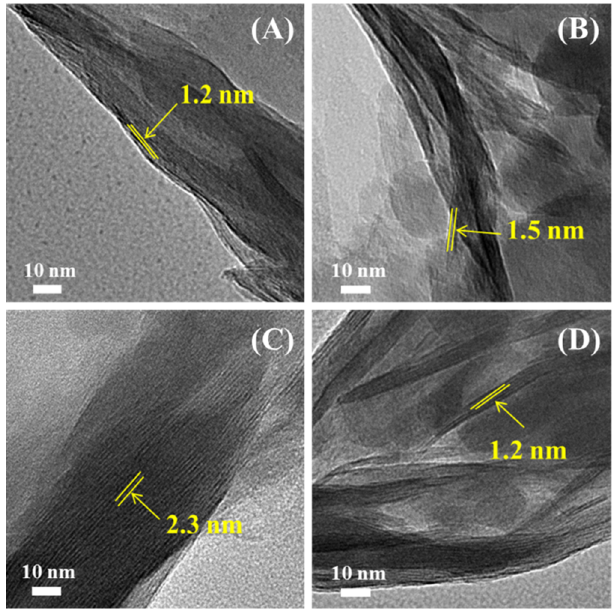
Figure 4. TEM images obtained for ( A ) Mt, ( B ) H-Mt, ( C ) P-Mt and ( D ) Si-Mt samples.